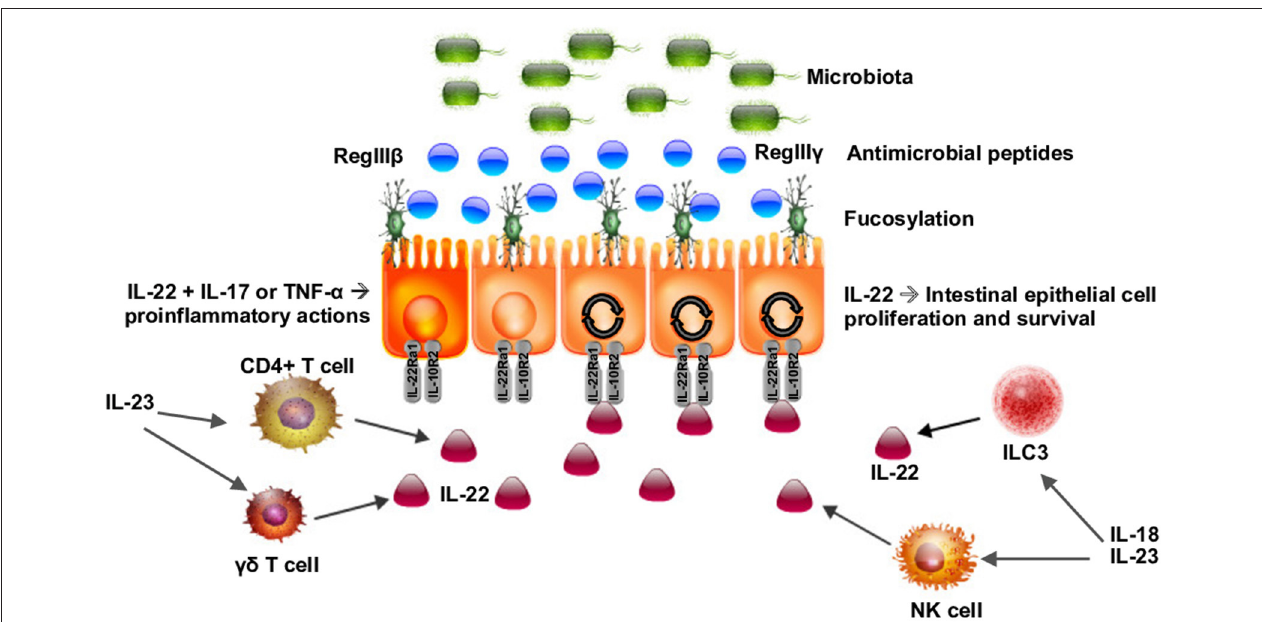
FIGURE 1 | SchematicofIL-22asakeyregulatoroftheinteractionofthemicrobiotawiththeintestinalepithelium. IL-22isproducedbyCD4 + and γδ Tcells aswellastype3innatelymphoidcells(ILC3s).IL-22actsonintestinalepithelialcellsinducingfucosylationandthereleaseofantimicrobialpeptides(AMPs),regulatingthe microbiota, and maintaining gut barrier homeostasis. IL-22 can act synergistically with IL-17 and TNF- α to activate a proinflammatory response to certain